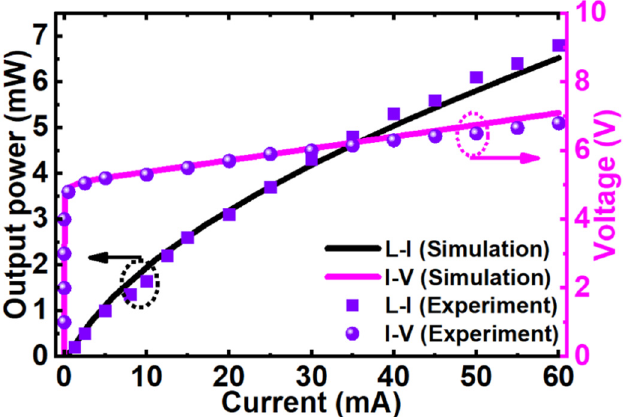
Figure 2. Measured and calculated light-current-voltage characteristics of LED 1 for model validation [21].